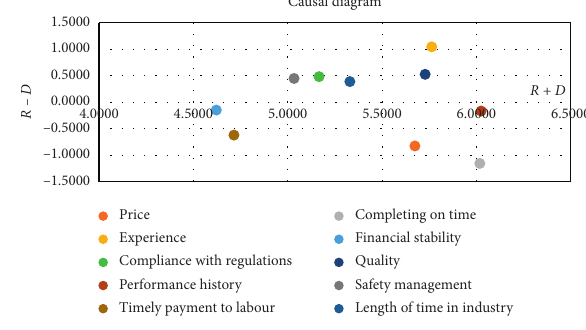
Figure 2: Causal diagram of criteria.